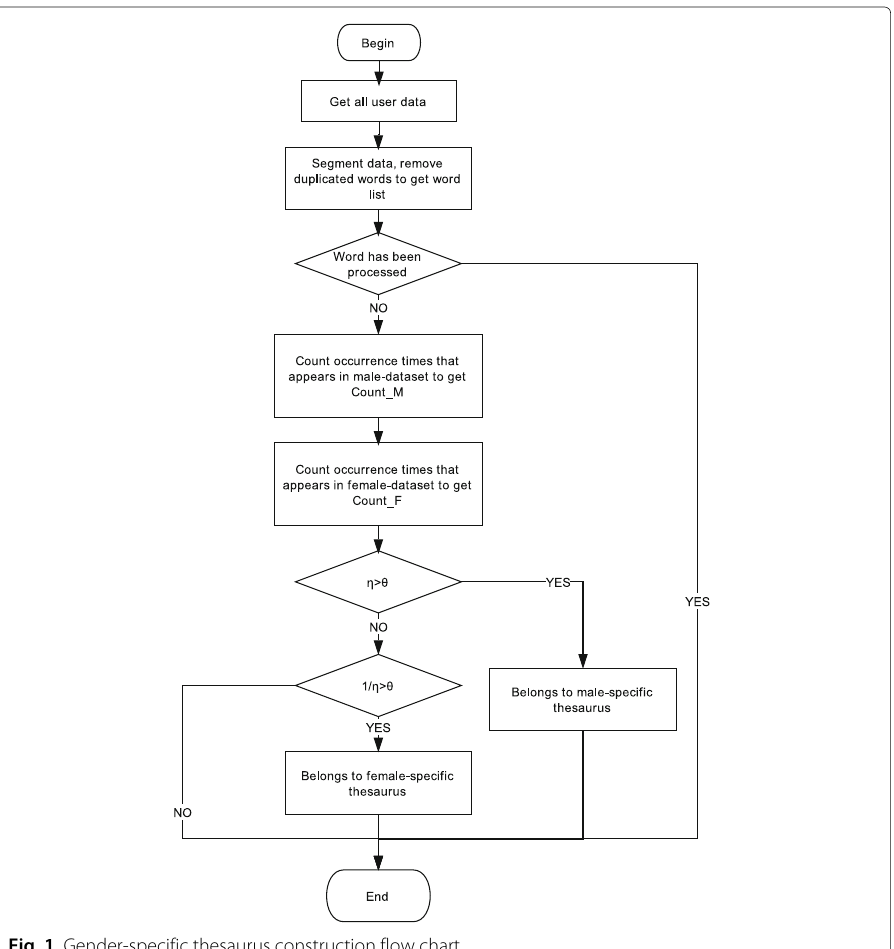
Fig. 1 Gender-specific thesaurus construction flow